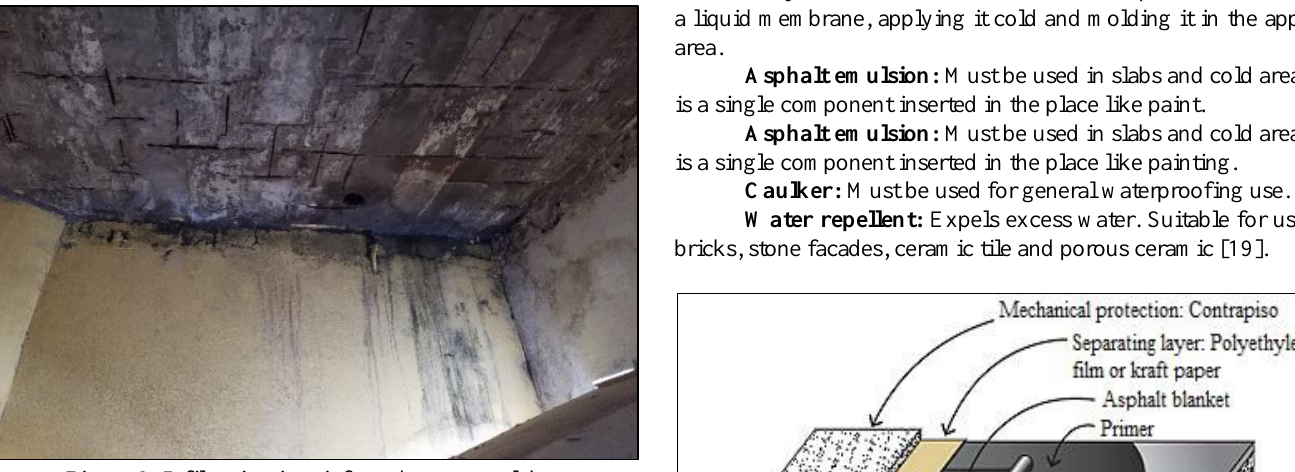
Figure 2: Infiltration in reinforced concrete slab.